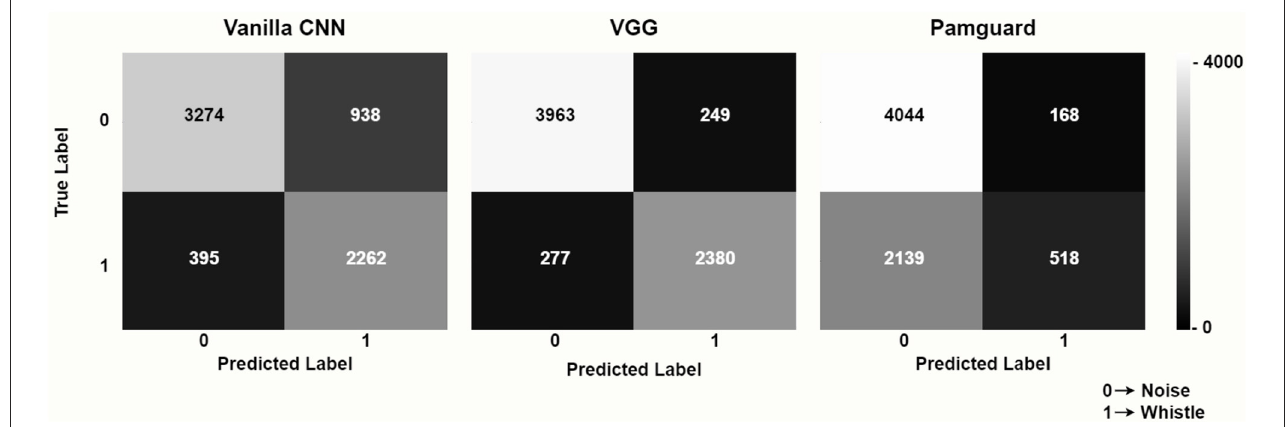
FIGURE3 Confusion matrices for the deep learning models (vanilla CNN and VGG with transfer learning) and for the PamGuard baseline.